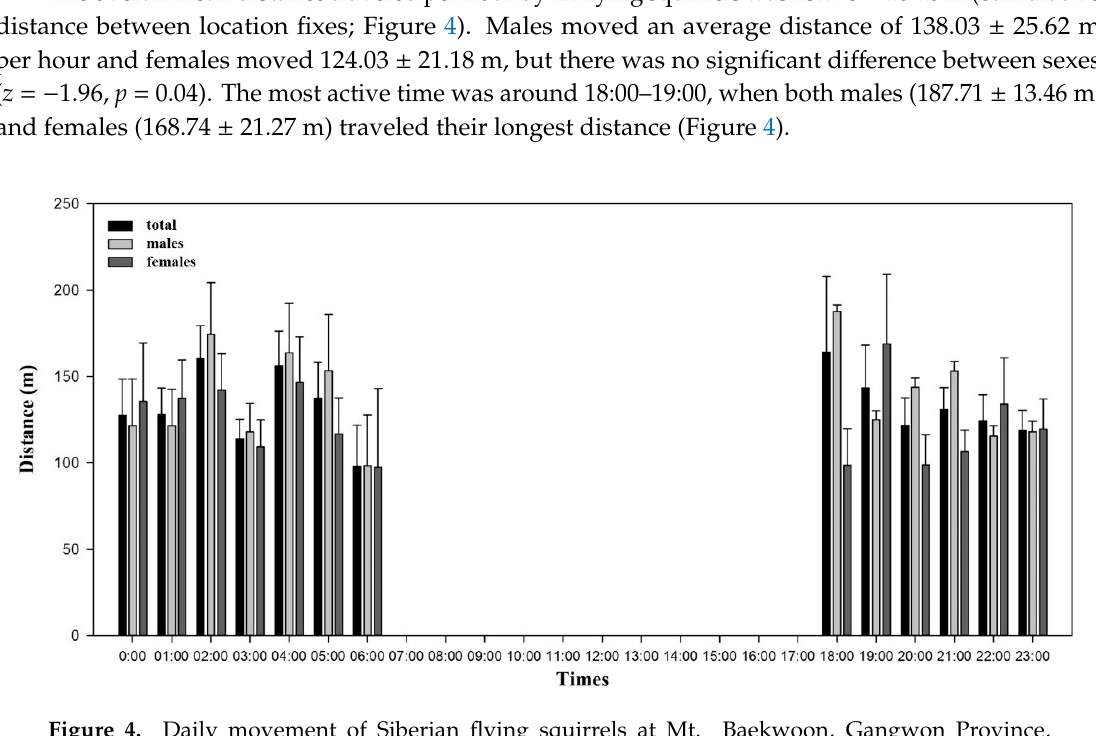
Table 5. Proportion of available habitat characteristics, proportion of habitat use from tracked locations, and Jacob’s preference index (PI) of Siberian flying squirrels by environmental factors at Mt. Baekwoon, Gangwon Province, South Korea.